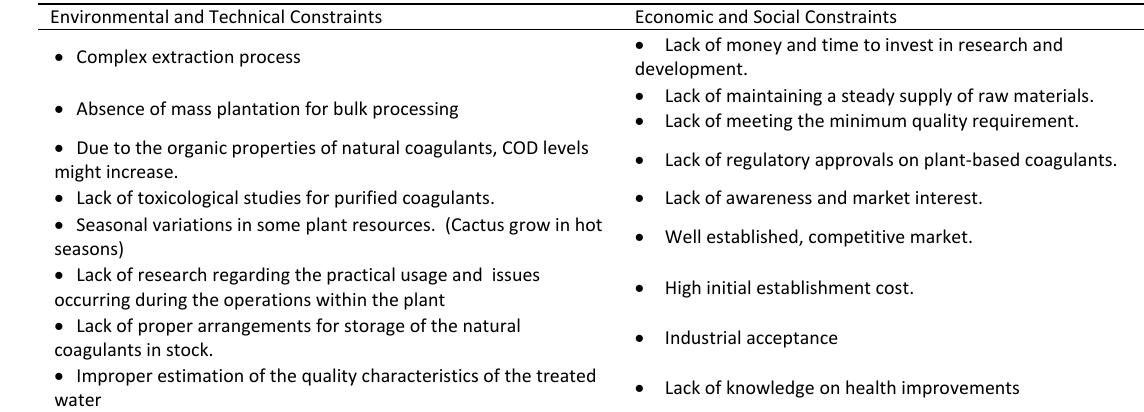
Table 5: Barriers in the commercialization of natural coagulants Environmental and Technical Constraints